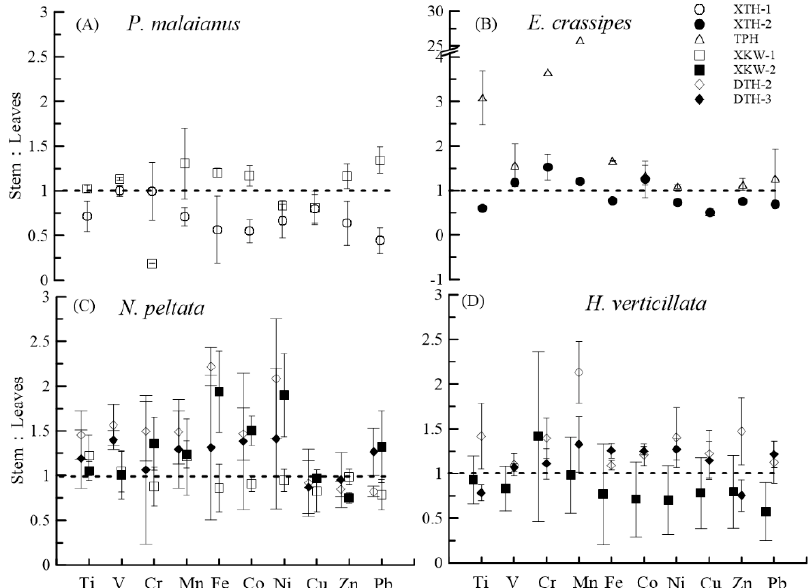
Figure 4. Heavy metal distribution in stems and leaves of different aquatic plants from different lake areas. Error bars represent the standard deviation (SD), dashed horizontal line represents the 1:1 ratio (stem: leaves) of metal concentrations quantified in plant tissues. ( A ) Potamogeton malaianus ; ( B ) Eichhornia crassipes ; ( C ) Nymphoides peltata ; ( D ) Hydrilla verticillata . Various positive correlations were found between aquatic plants, water, and sediment (Figure 5).